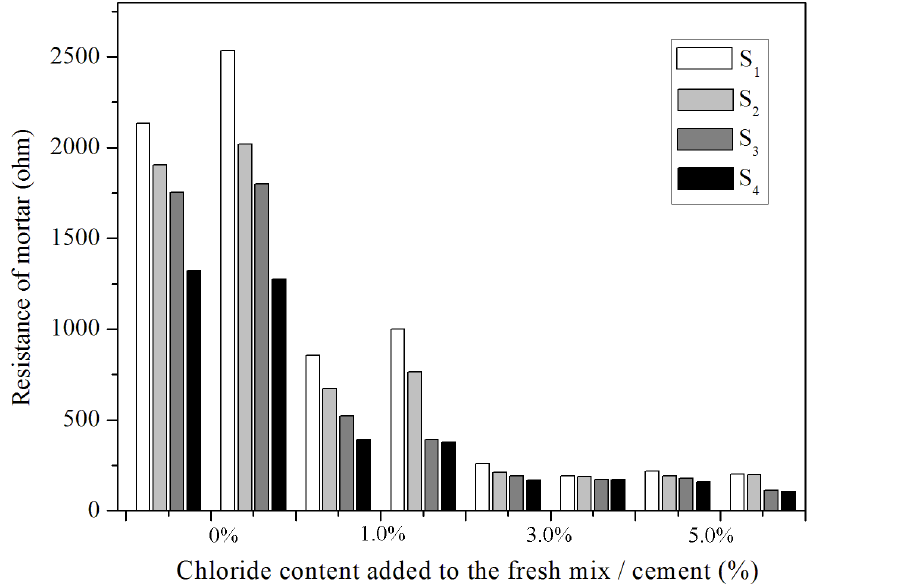
Figure 4. The resistance values of cement mortars with different chloride contents ( A to D